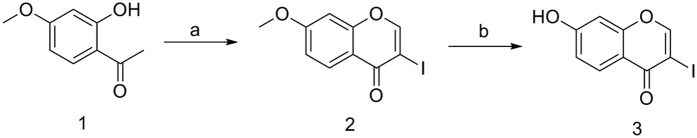
Synthesis of intermediate 3.Reagents and conditions: (a) (i) DMF/DMA, 95 °C, 3 h, (ii) TCM, pyridine, I2, rt; (b) toluene, AlCl3, 100 °C.